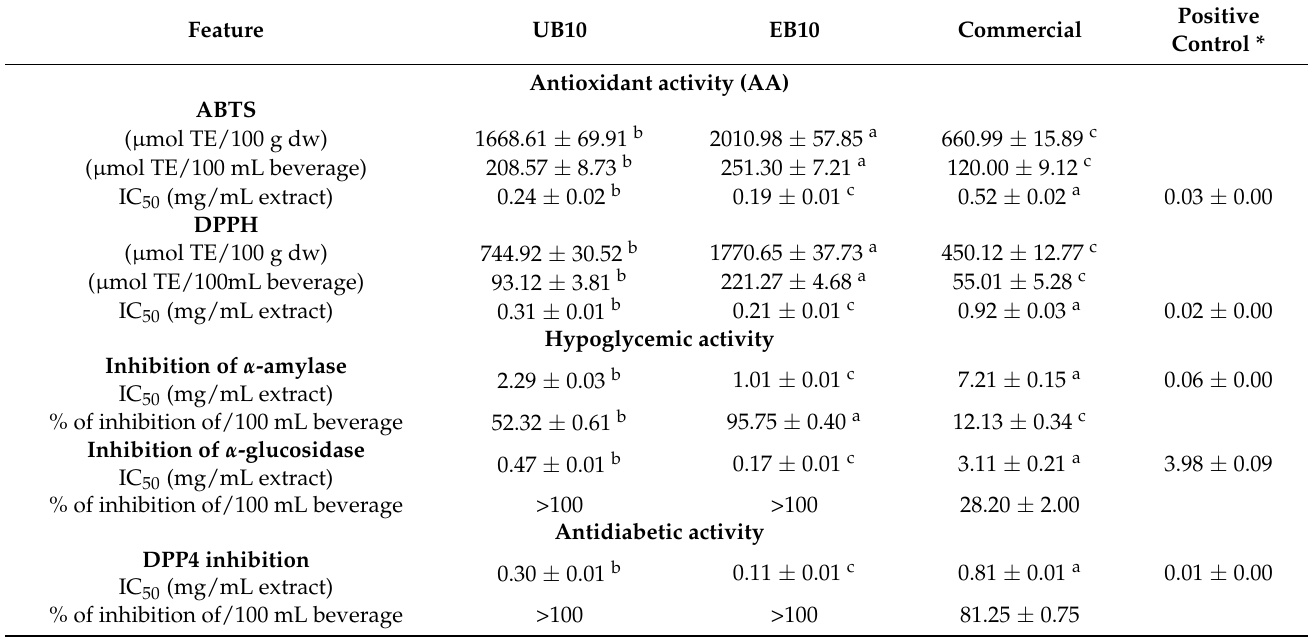
Table 3. Antioxidant activity, hypoglycemic activity, and antidiabetic activity of unprocessed and extruded sesame seeds byproduct flour beverages, and commercial